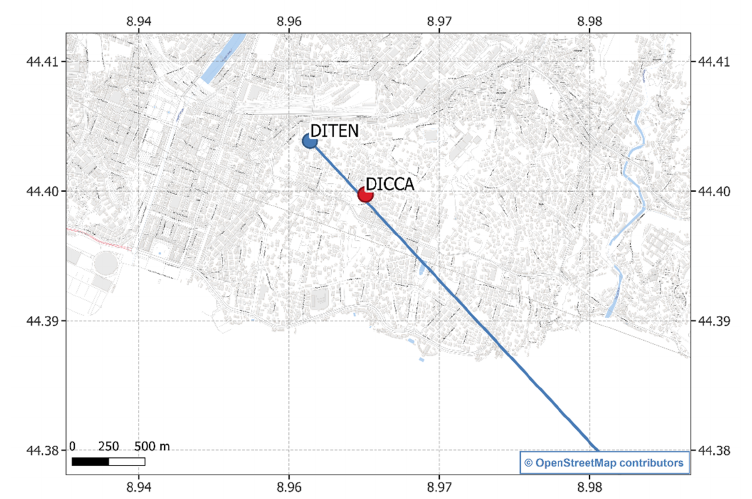
Figure 1. The location of the SRS dish at the University of Genova—DITEN department (blue circle, Lat: 44.4031; Lon: 8.9587; Altitude 70 m.a.s.l.) and TBRG at the Hydraulic Laboratory of the University of Genova—DICCA department (red circle, Lat: 44.3998; Lon: 8.9636; Altitude 45 m.a.s.l.). The blue line represents the ground projection of the path from the dish toward the Turksat 42° E constellation, chosen for this